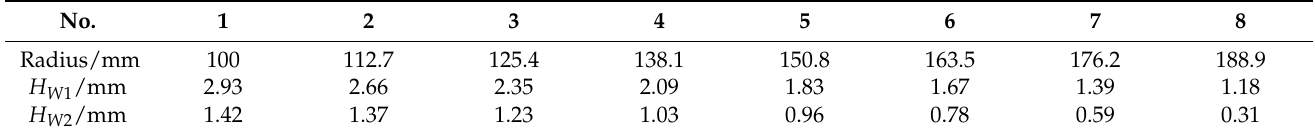
Table 2. The fiber waviness height using two different rollers.